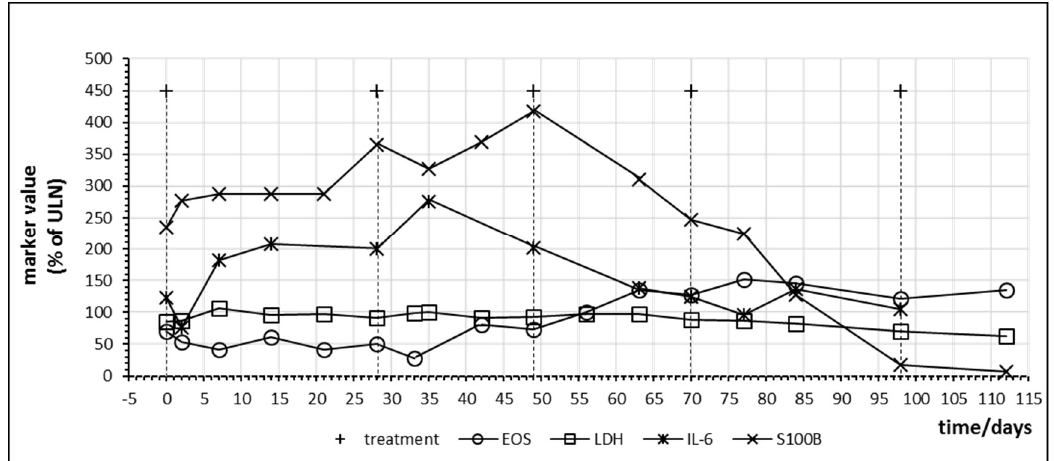
Figure 8. Time course of immune and tumor cell damage markers during checkpoint inhibitor treatment starting at day 0 in patient no. 17 receiving four cycles of nivolumab plus ipilimumab combination treatment followed by nivolumab monotherapy. Interval between the first and second cycle was prolonged due to gastritis of unknown cause. For better visualization, S100B levels are plotted at ¼ of actual values. EOS = eosinophiles.